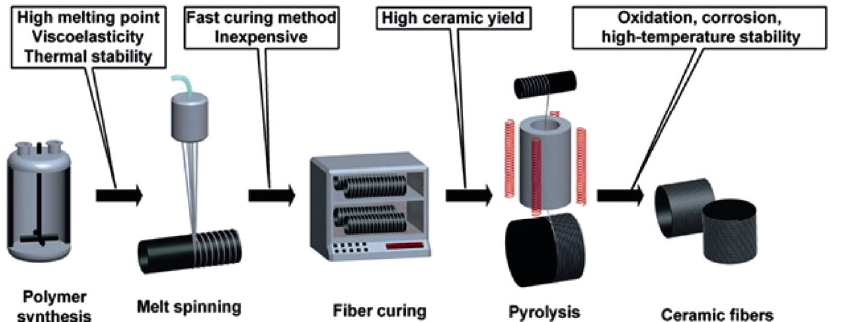
Fig. 9 Manufacturing procedures for polymer-derived ceramic fibers. Reproduced with permission from Ref. [86], © WILEY-VCH Verlag GmbH & Co. KGaA, Weinheim 2014.